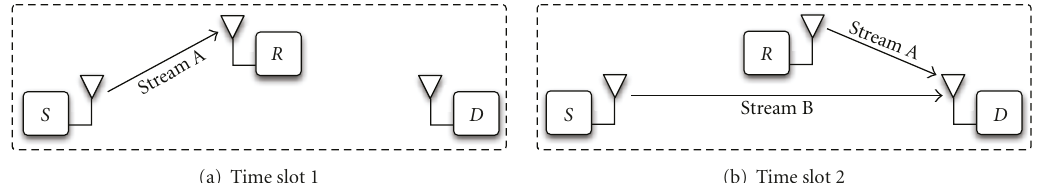
Figure 6: Node configurations and activity in the amplify and forward system.